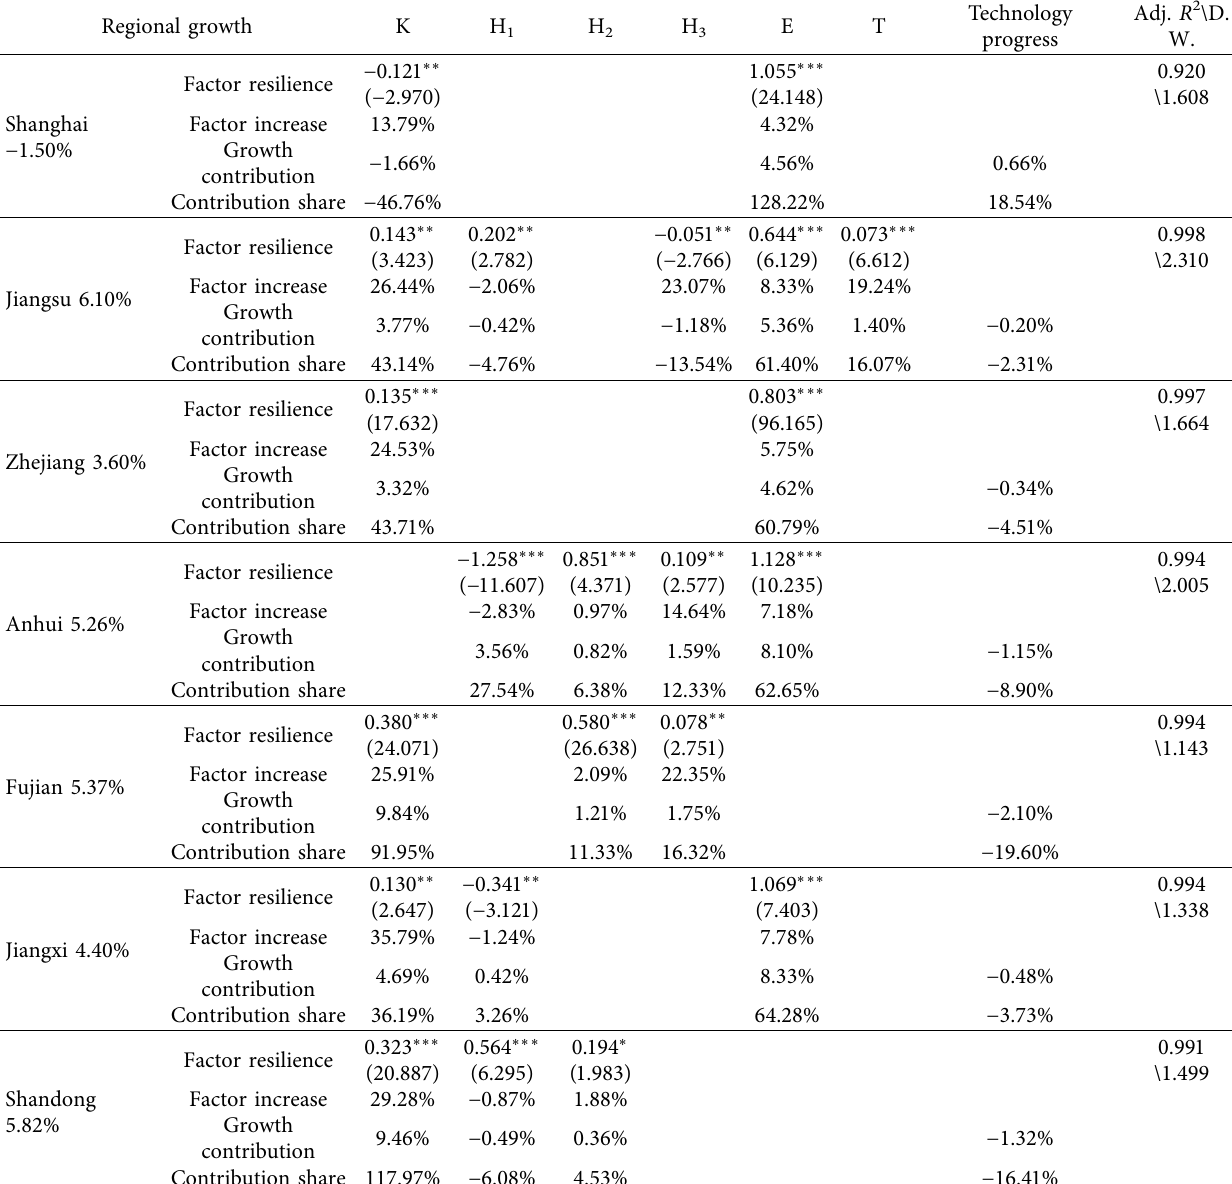
Table 2: Output elasticity of secondary